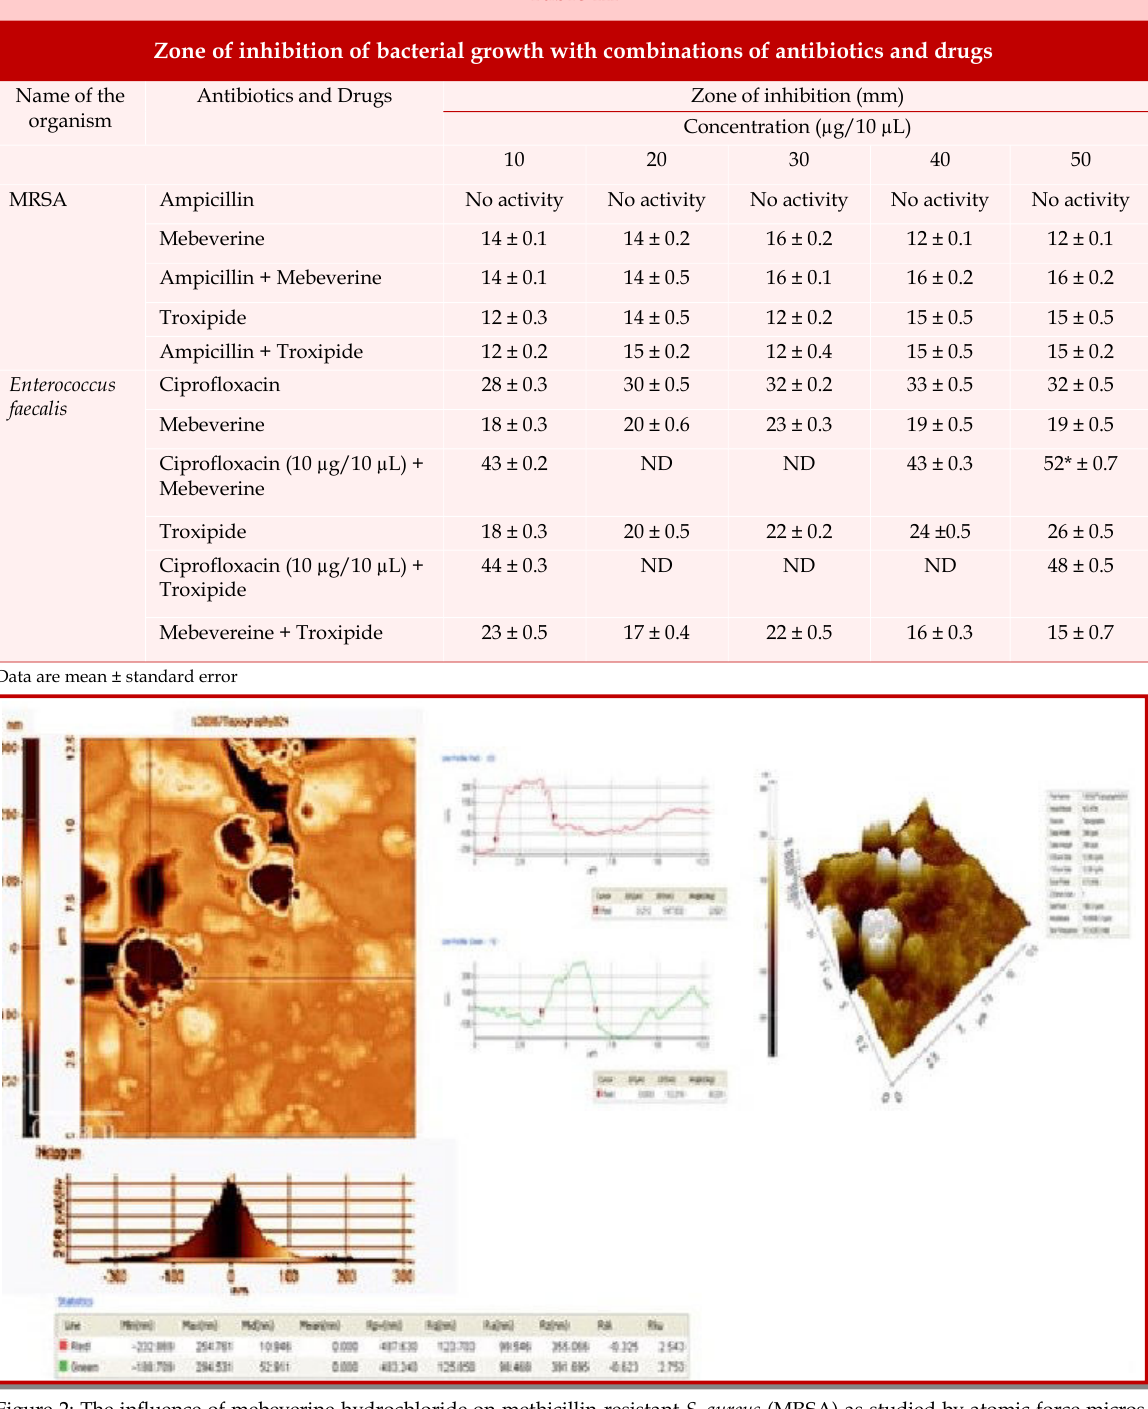
Figure 2: The influence of mebeverine hydrochloride on methicillin-resistant S. aureus (MRSA) as studied by atomic force micros-